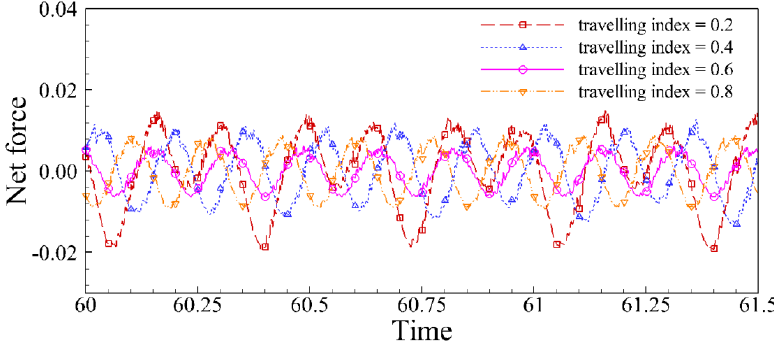
Figure 14. Time history of the net force of carangiform fish at different travelling indices.